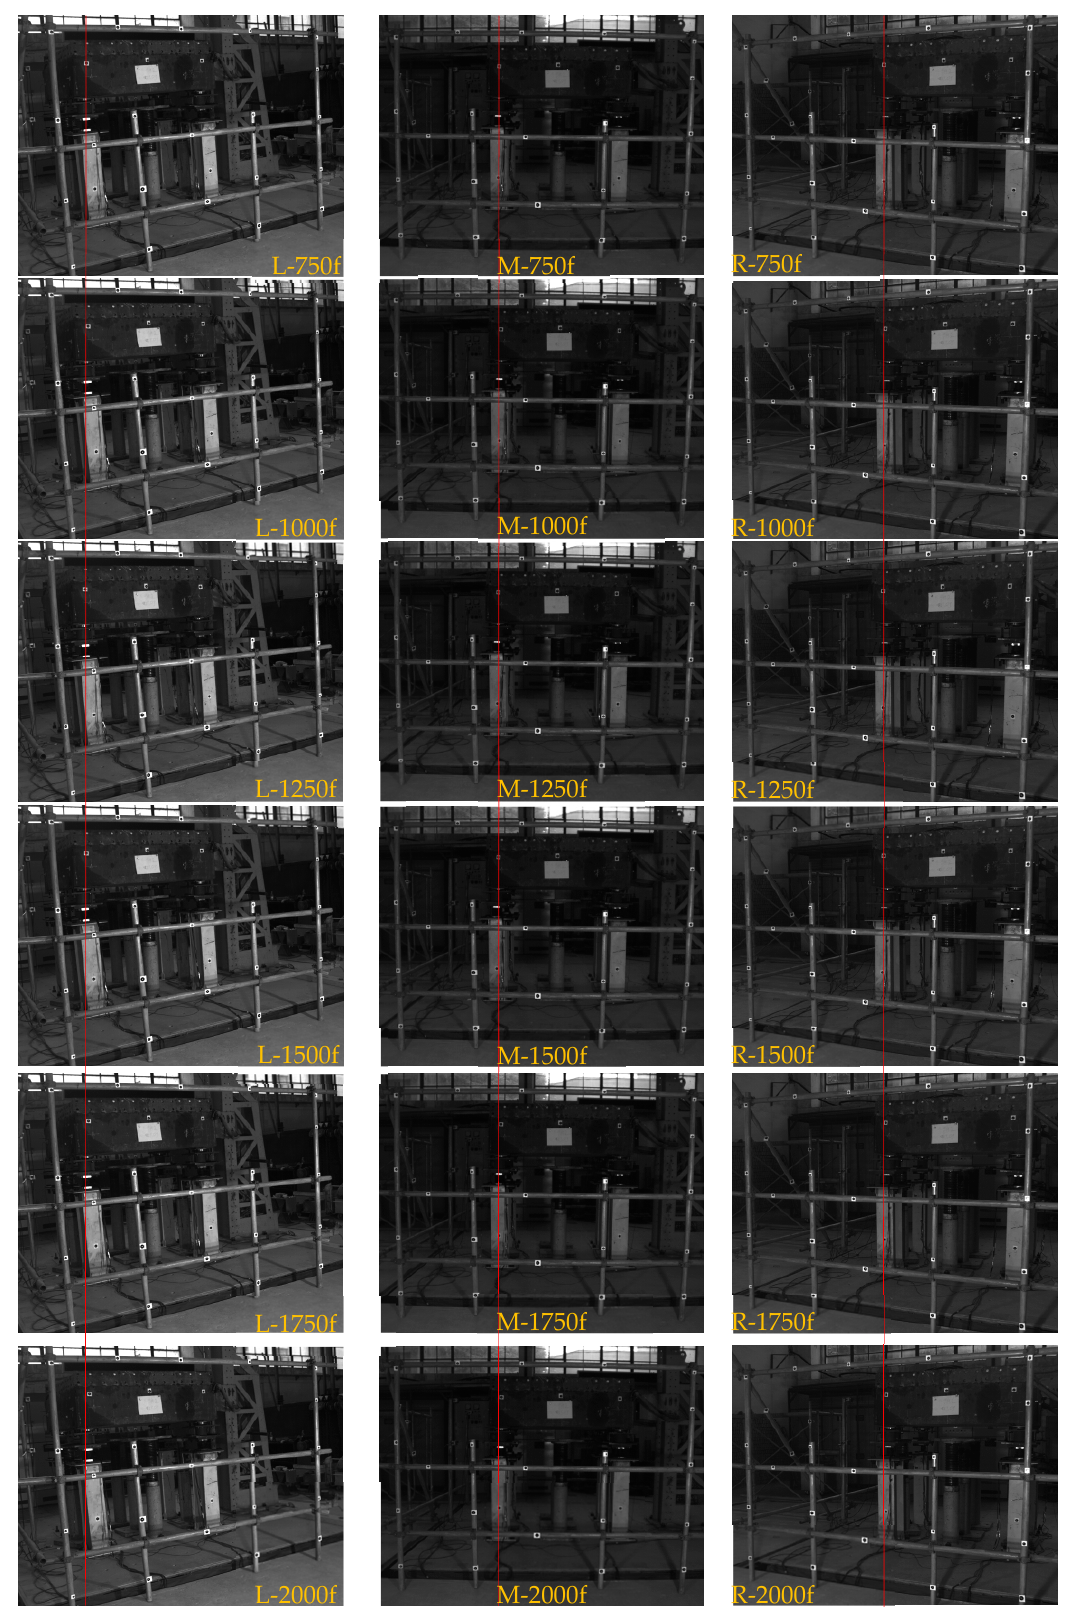
Figure 5. The images from tri-camera image sequences at 750 frame, 1000 frame, 1250 frame, 1500 frame, 1750 frame and 2000 frame by the left-camera (L), middle-camera (M) and right-camera (R), respectively.